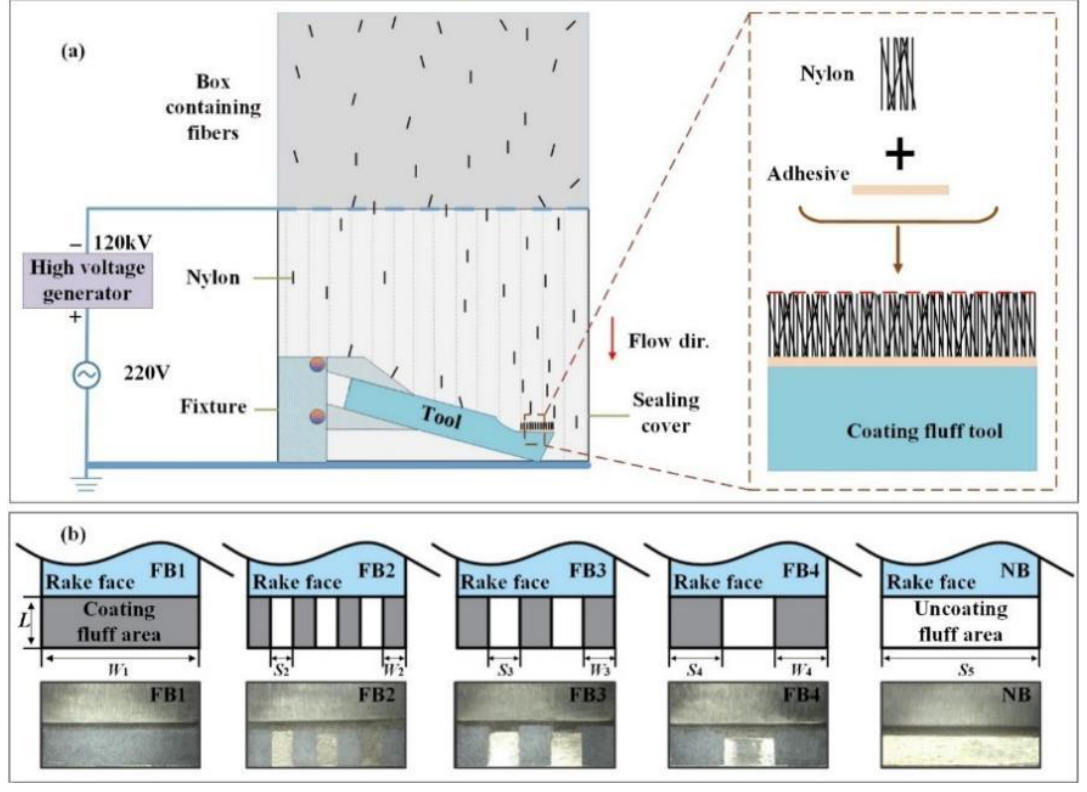
Figure 2. ( a ) Principle of electrostatic flocking; ( b ) Design styles and surface morphology of five broaches.